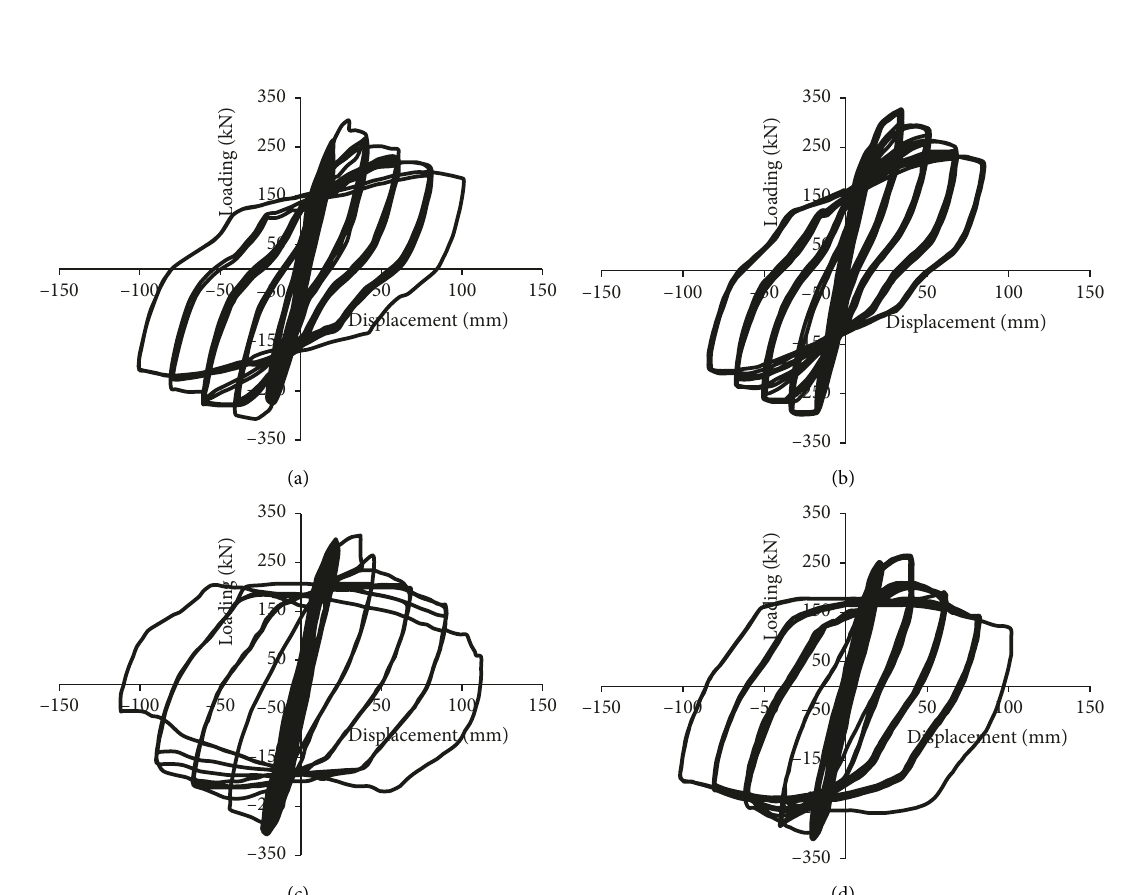
Figure 5: Hysteresis curves of the specimens. (a) W01. (b) W02. (c) W03. (d)